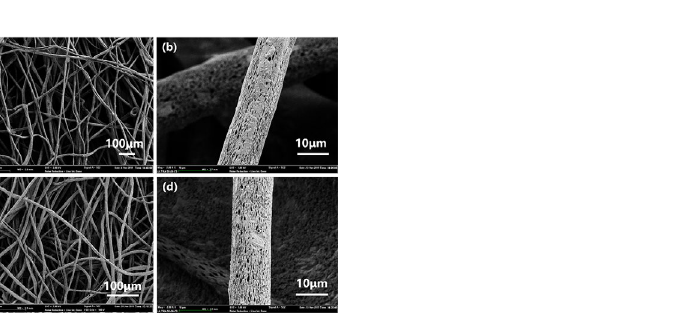
Figure 13. Relation Curve between Reabsorption Efficiency and Cycle Times of 3% MMT and 5% CTS-MMT Composite Fiber Membranes.